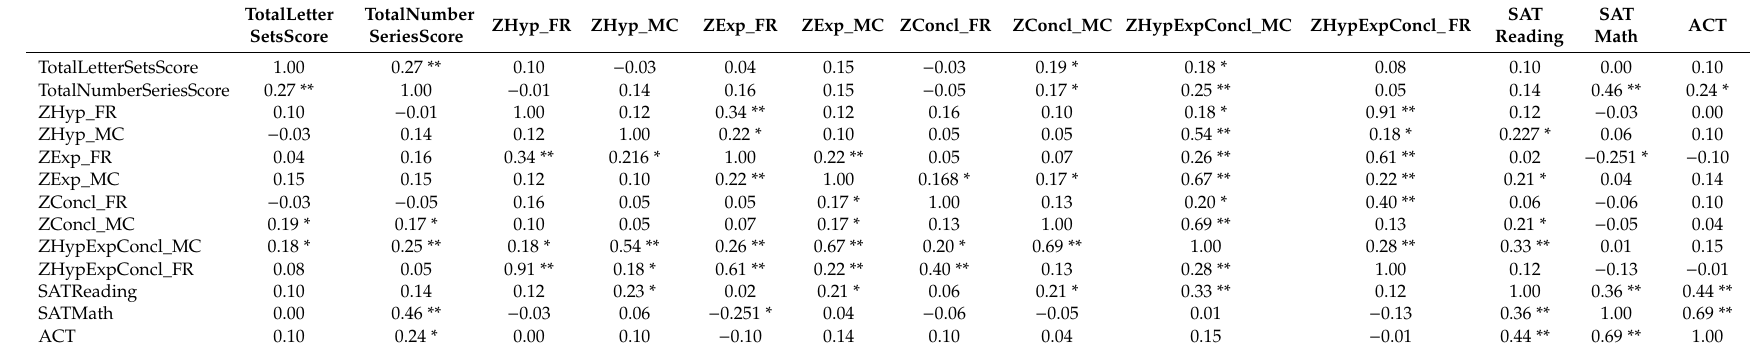
Table 10. Study 2 Z -Score